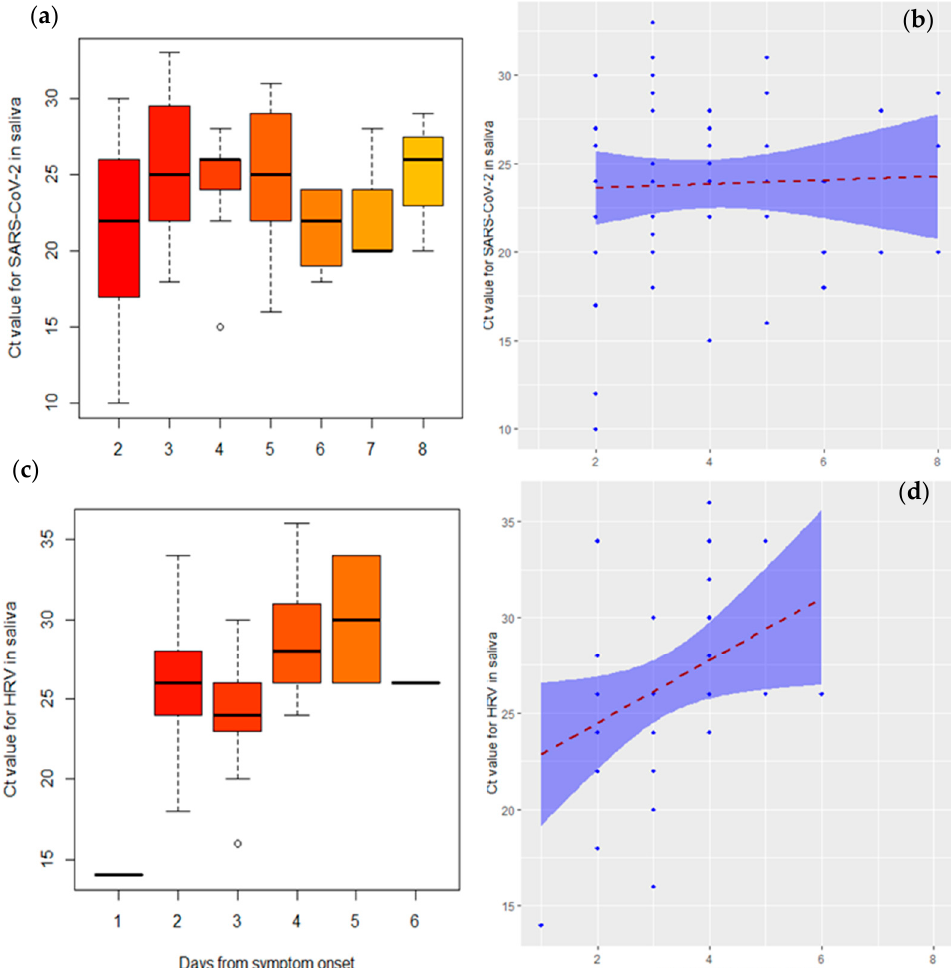
Figure 2. Boxplot and scatter plot of Ct values of SARS-CoV-2 ( a , b ) and HRV( c , d ) saliva-positive patients with ARI. The R function lm() was used to compute linear regression model. The blue-shaded areas correspond to the 95% confidence limits. The number of samples positive to the respiratory viruses other than SARS-CoV-2 and HRV was too small to be plotted.